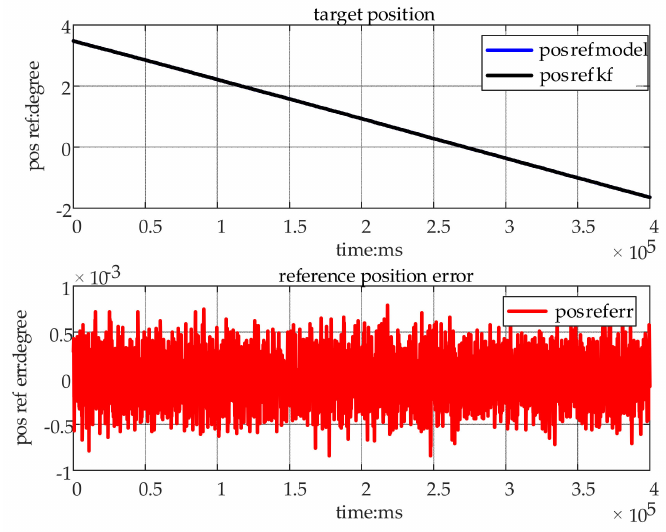
Figure 10. Measured curve of the target